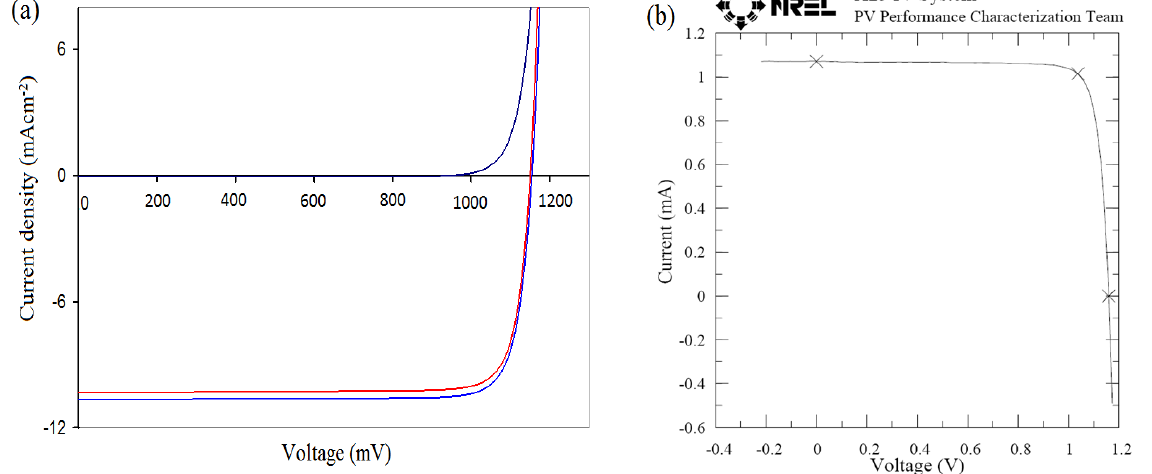
Figure 6. Experimentally observed I-V characteristics for graded bandgap devices fabricated using AlGaAs